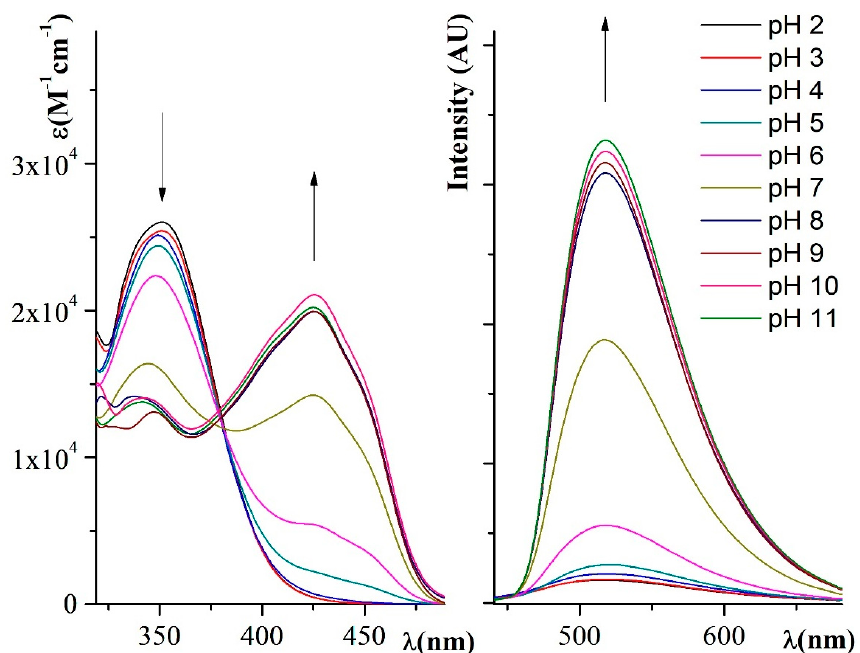
Figure 1. UV–Visible (UV–Vis) spectral titration of BTABr 100 µ M in water using Britton–Robinson bu ff ers from pH = 2.0 to pH = 11.0 (on the left). Fluorescence spectral titration of BTABr 20 µ M in water using Britton–Robinson bu ff ers from pH = 2.0 to pH = 11.0 (excitation wavelength of 350